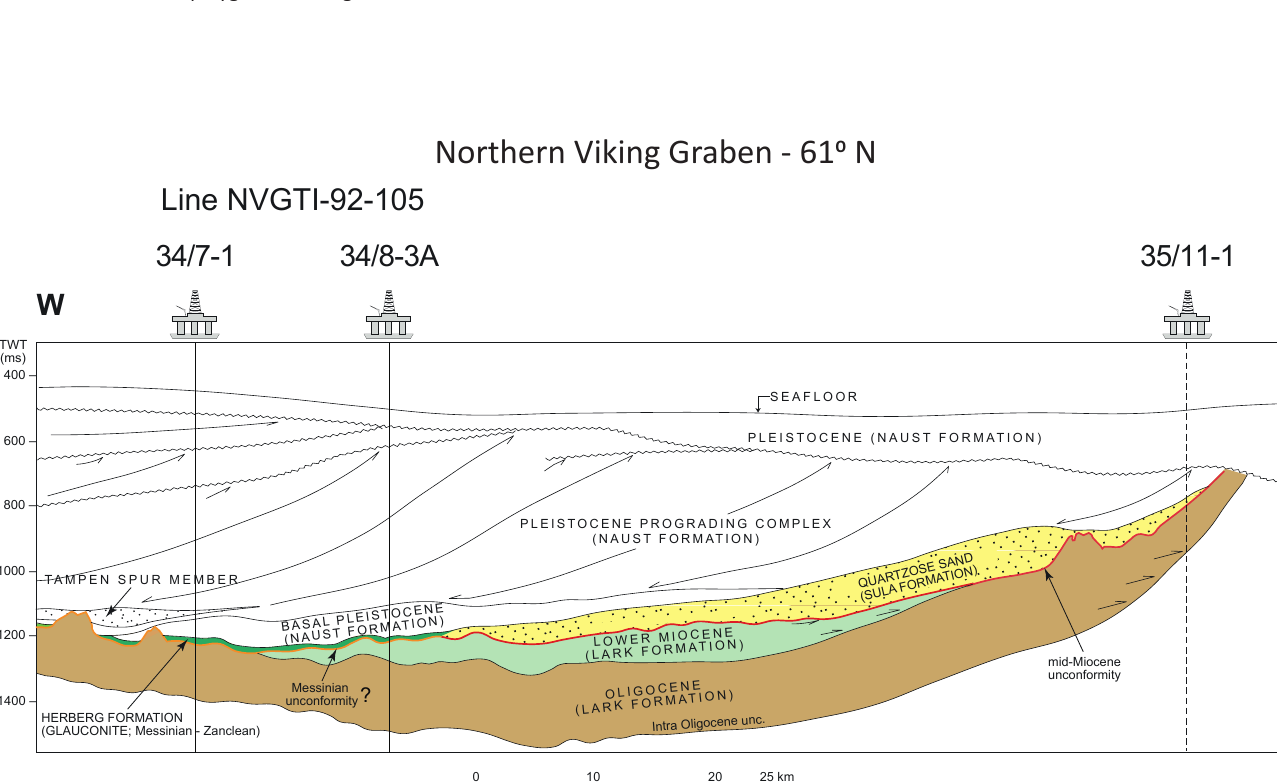
Figure 20. E–W transect of the northern North Sea at about 61°N illustrating the main sequences and sedimentary architecture of the post-Eocene strata. Note the Messinian (beige) and the mid Miocene (red) unconformities (see Fig. 2 for location; modified after Eidvin & Rundberg, 2001; Rundberg & Eidvin,